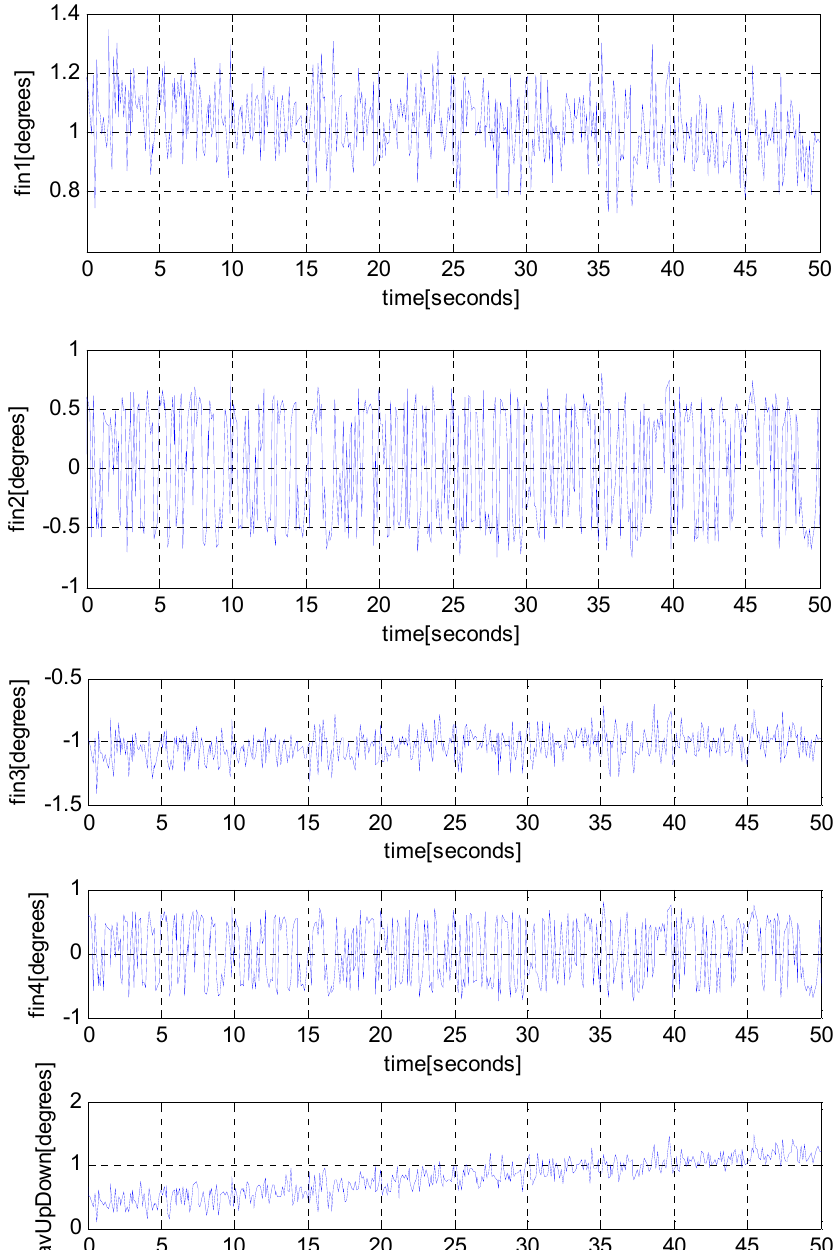
Figure 9. The deflection angles with respect to time (controllers considering noisy environments and fuel consumption).